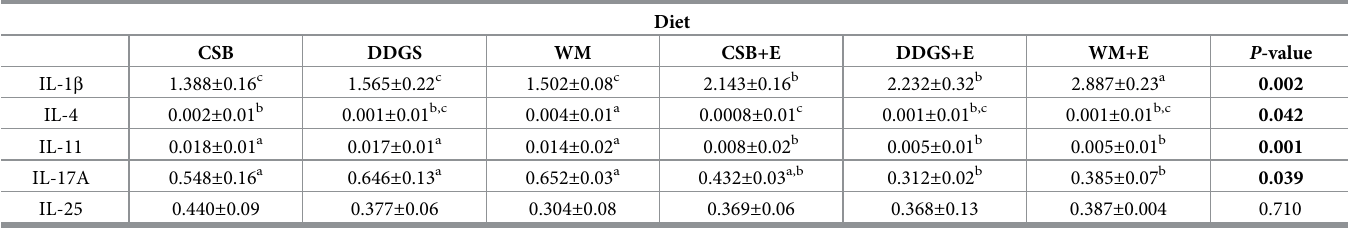
Table 4. Concentration (pg/mg total protein) of cytokines in ileal tissue of pigs fed high fiber diets with or without enzyme supplementation for 28 days.